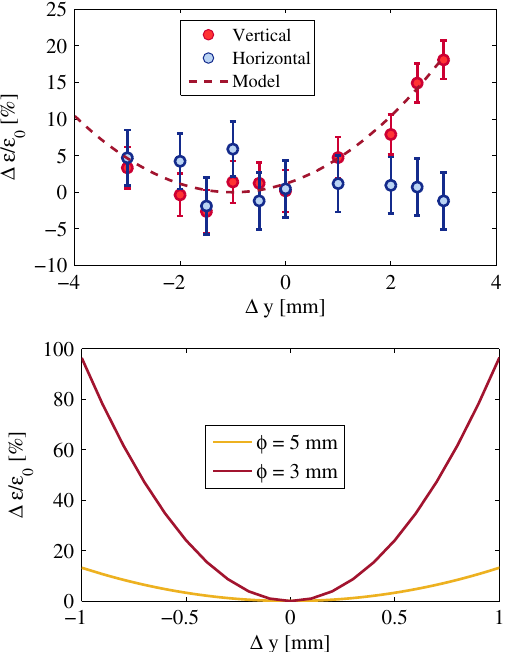
FIG. 24. Measured projected emittances with the 9 mm diam- eter hole as a function of the collimator offset making the beam passing through the 9 mm diameter hole of the collimator and comparison with Eq. (11) (top plot). Expectations from the model assuming several hole diameters (bottom